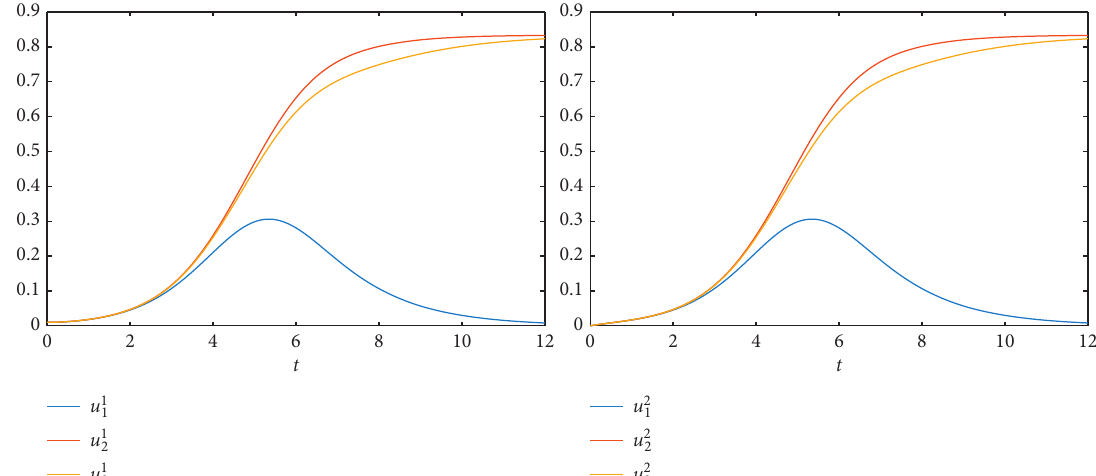
Figure 2: Simulation of (42) with (40).